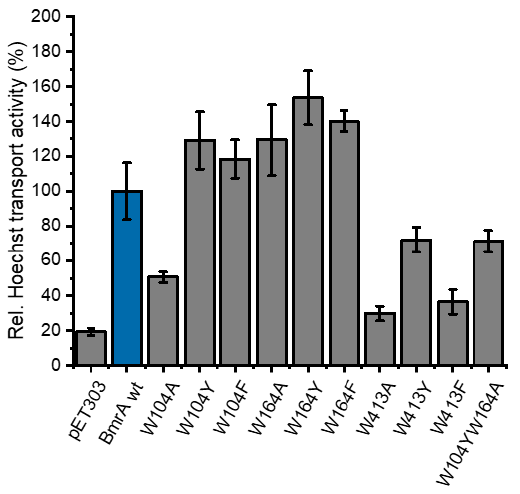
Figure 4. Transport activity of BmrA wt and single Trp variants. The three Trp residues (W104, W164, and W413) of BmrA were individually replaced by Ala, Tyr, or Phe, respectively (see Figure 1A). The Hoechst transport activity of inverted vesicles containing the respective BmrA variants was determined. Inverted vesicles missing BmrA were used as negative control (pET303). Additionally, the results for the double mutant W104YW164A, where only the Trp residue of the NBD is present, are shown. Data show a triple determination of two independent, inverted membrane vesicle preparations each (±SD).